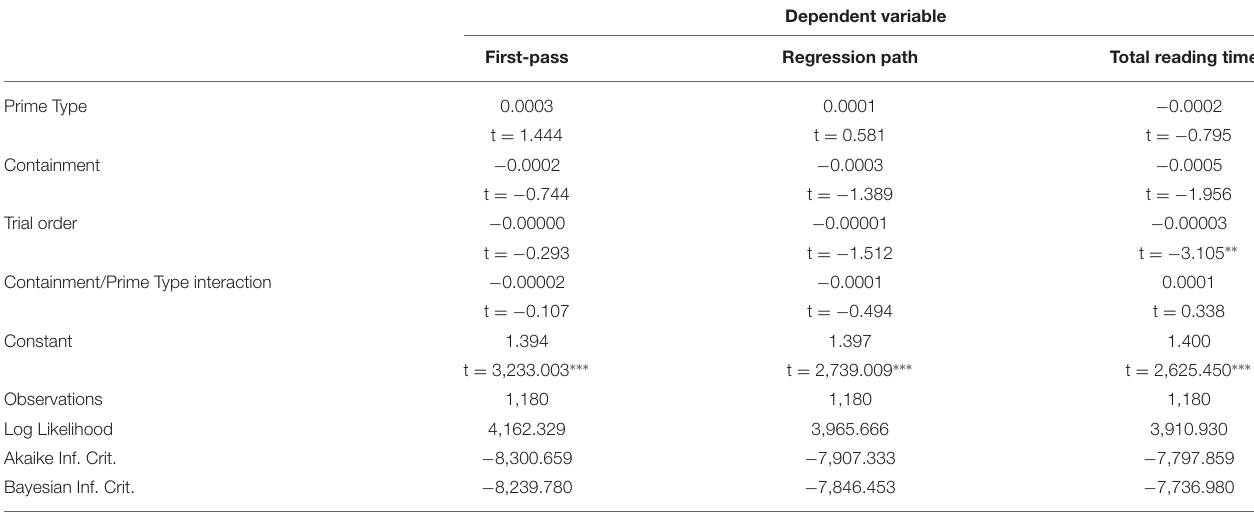
TABLE 3 | Regression analysis of reading times in the ADJECTIVE region of Experiment 1.